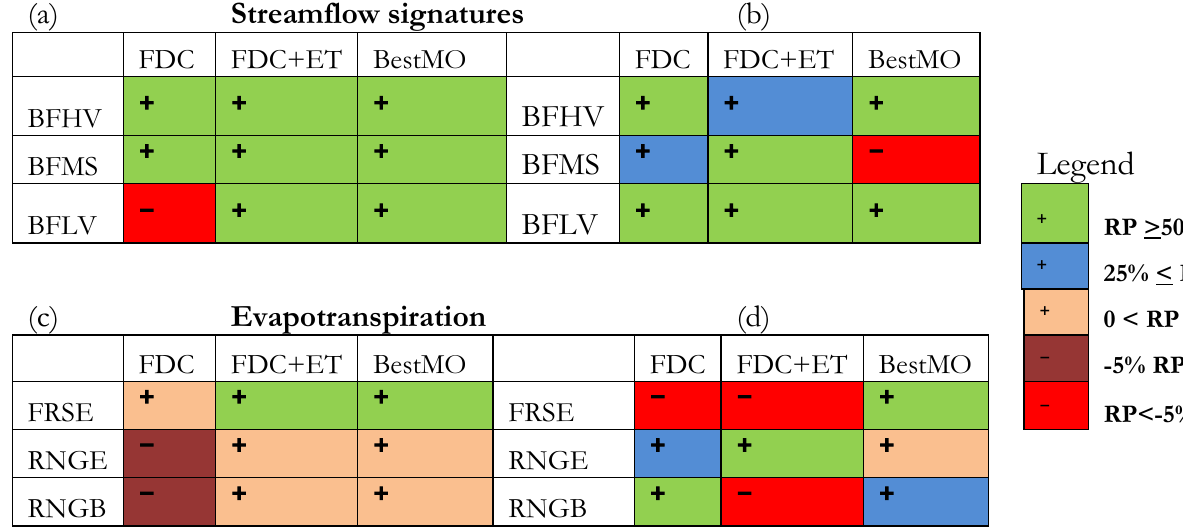
Figure 14. The relative performance of calibrated SWAT compared to the baseline model for streamflow signature bias measures for the Nyangores ( a ) and Mara ( b ) Rivers, and for evapotranspiration using correlation ( c ) and percent of bias ( d ). FDC: calibration using only streamflow signature measures; FDC + ET: calibration using streamflow signature measures and remote sensing-based evapotranspiration; BestMO: automatic multi-objective calibration based on the selected best parameter set from the Pareto set solutions.